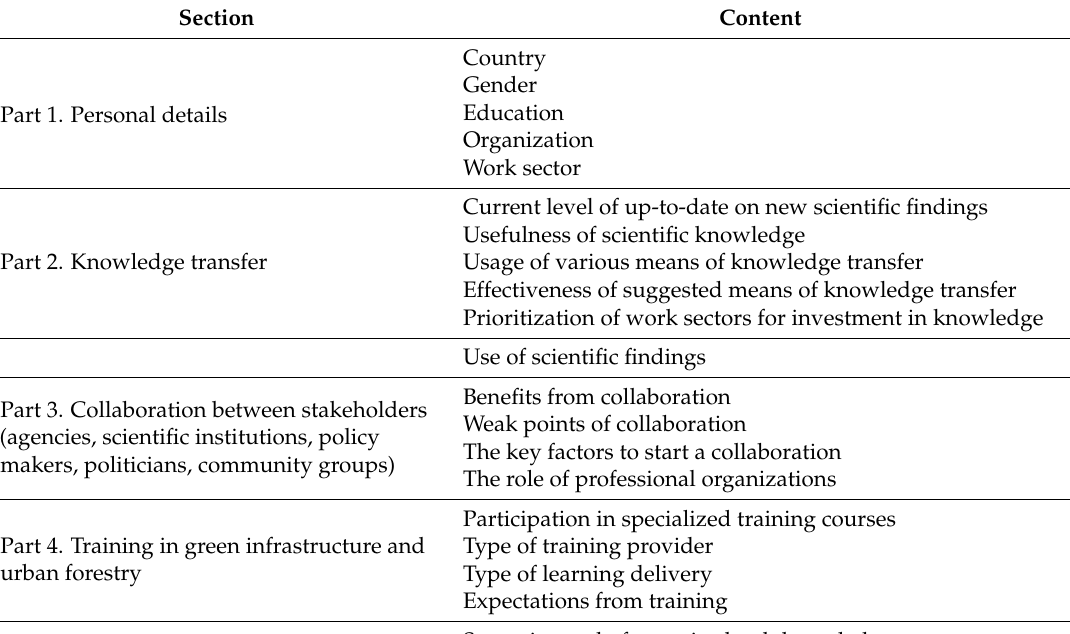
Table 1. Structure of the questionnaire administered to all respondents (adapted from